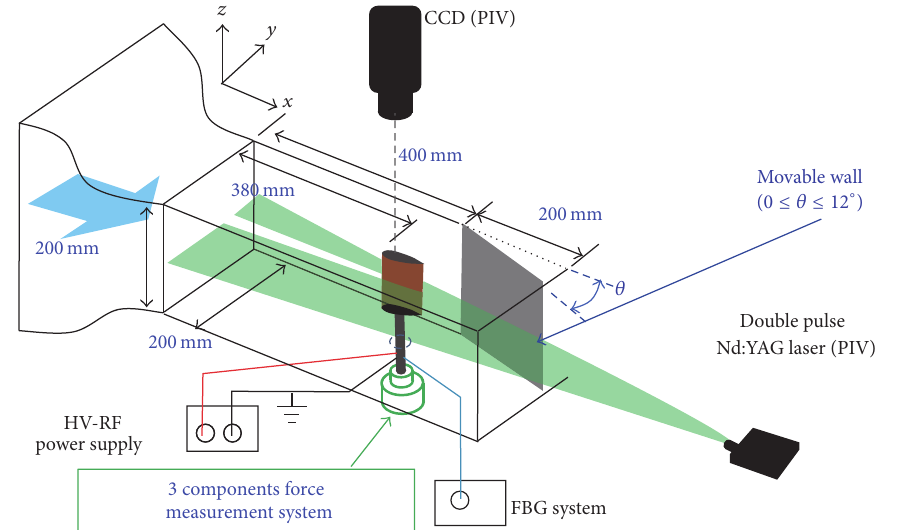
Figure 3: Schematic illustration of experimental setup. The side wall of the test section near the airfoil suction surface is hinged at 400 mm downstream of the entrance and can be pivoted over a range of 0 ∘ ≤ 𝜃 ≤ 16 ∘